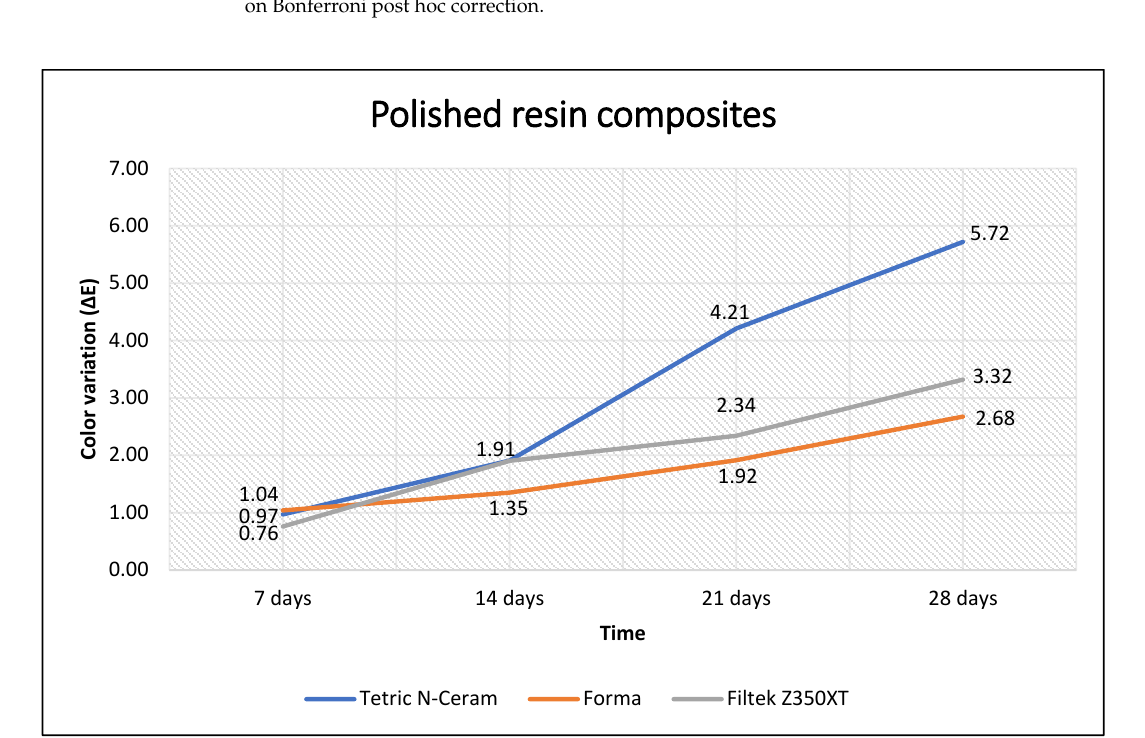
Figure 2. Color variation (ΔE) of polished resin composites according to immersion time.